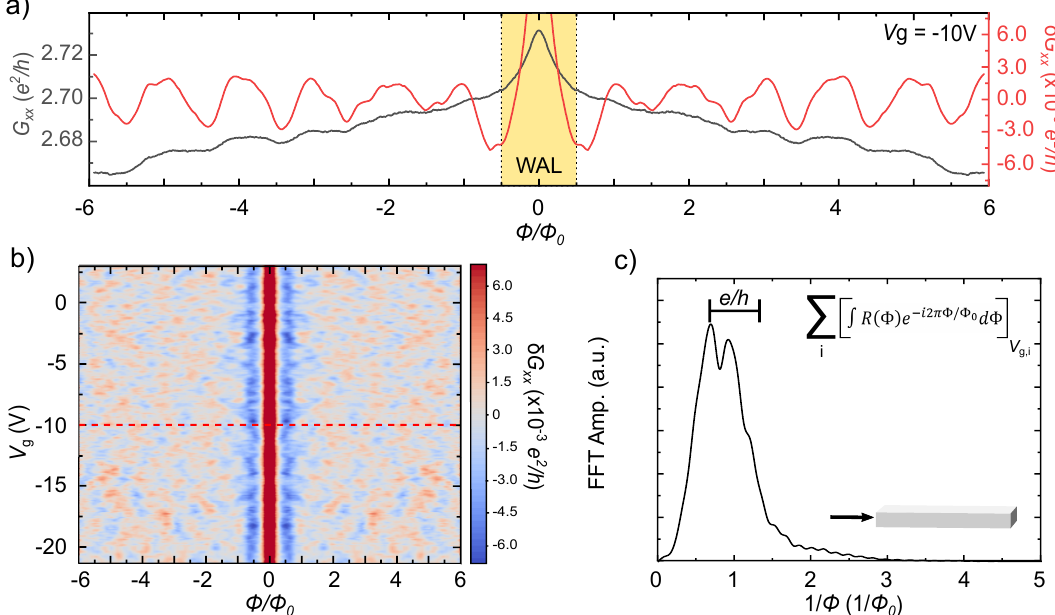
Figure 3: Gate-dependent magnetoconductance oscillations of the narrow nanorib- bon in a parallel applied magnetic field. a) The magnetoconductance of a narrow nanoribbon device shows periodic Aharonov–Bohm oscillations, exemplary shown = − 10V before (black curve) and after subtracting a slowly at a gate voltage of V g varying background (red curve). The low field is governed by the weak antilocal- ization effect (WAL). b) A set of magnetoconductance measurements performed at different gate voltages V . Each δ G curve shows a dominant WAL feature at low xx g ∼ 0, red area) as well as flux quantum-periodic, symmetric oscillations fields ( Φ / Φ 0 | > 0). The flux-quantum periodicity of at higher magnetic field strengths ( | Φ / Φ 0 observed oscillations is further verified in the fast Fourier transformation performed on each dataset. In c) the sum of all FFT amplitudes of each respective scan are shown. The scale bar highlights the error of expected frequencies for the observation of flux-quantum periodic AB-type oscillations due to geometric